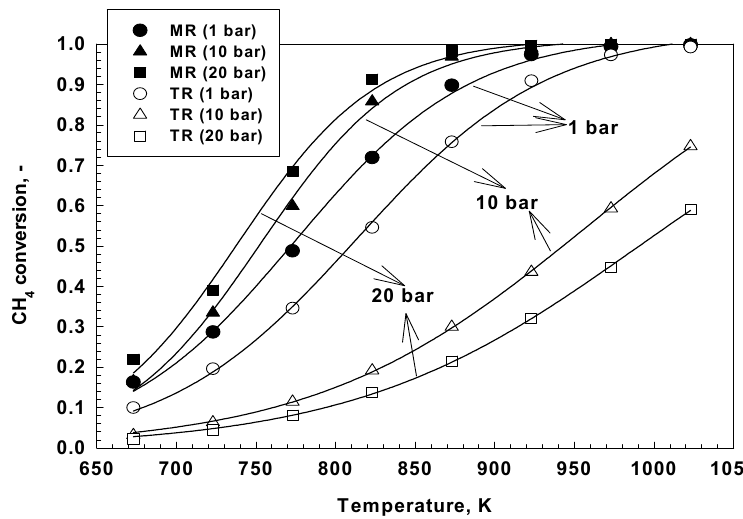
Figure 6. Methane equilibrium conversion in conventional system and comparison with membrane reactors at different pressures.